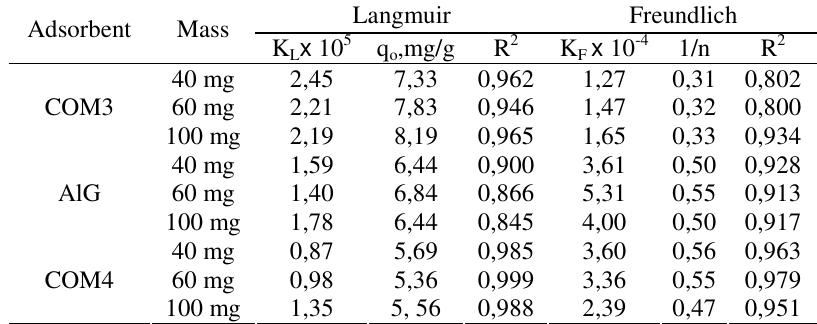
Table 1. Values of K 100 mg of